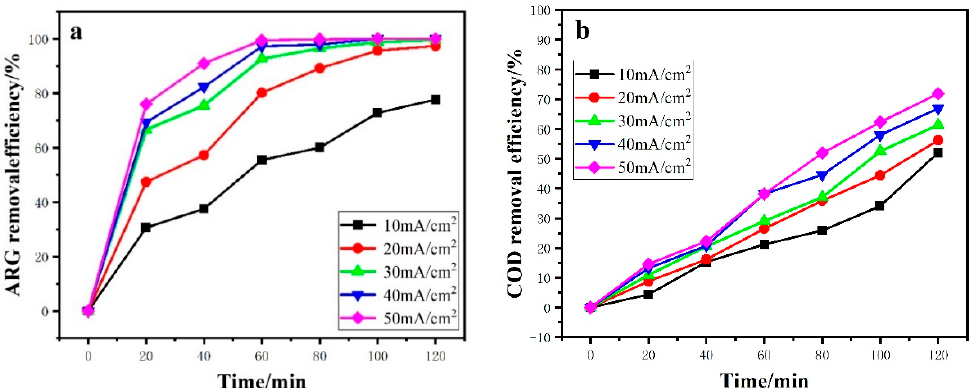
Figure 6. Effect of current density on ARG removal efficiency ( a ) and COD removal efficiency ( b ). Other operating conditions: ARG concentration of 100 ppm and temperature of 25 °C . Table 2. Effect of different factors on ARG degradation by using the 2.5D electrode system.